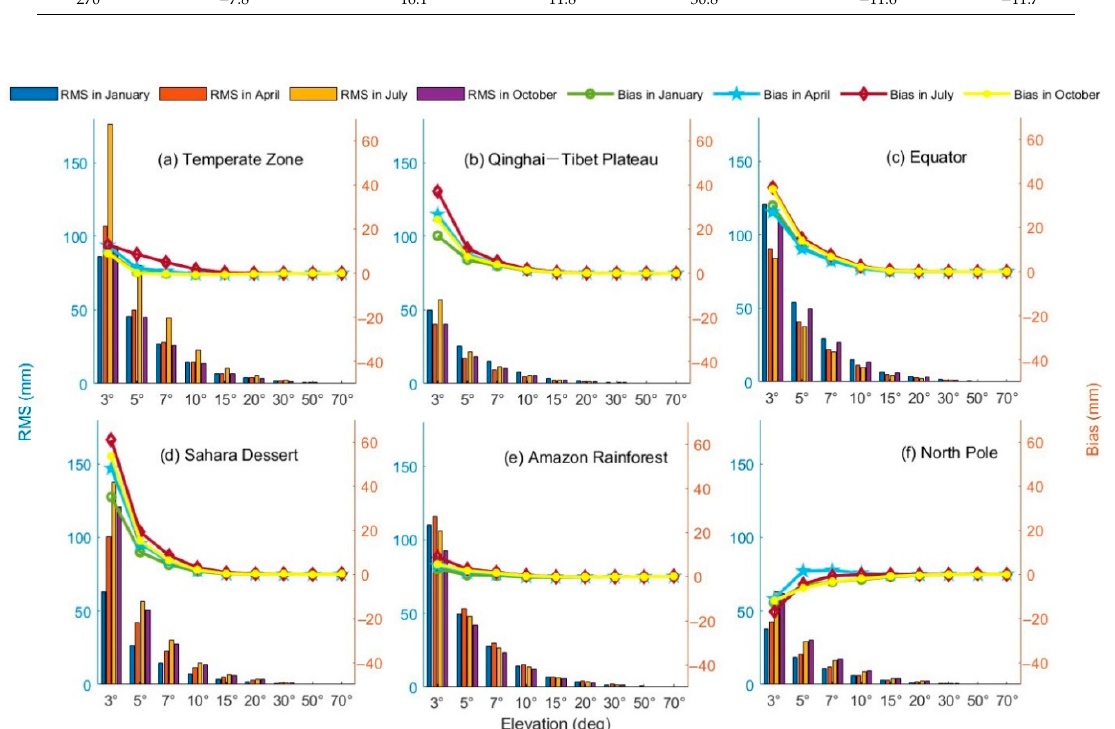
Figure 4. The RMSs and biases of VMF1 for the six regions at the different elevations (70°, 50°, 30°, 20°, 15°, 10°, 7°, 5°, and 3°): ( a ) Temperate Zone ( b ) Qinghai—Tibet Plateau ( c ) Equator ( d ) Sahara Dessert ( e ) Amazon Rainforest ( f ) North Pole.